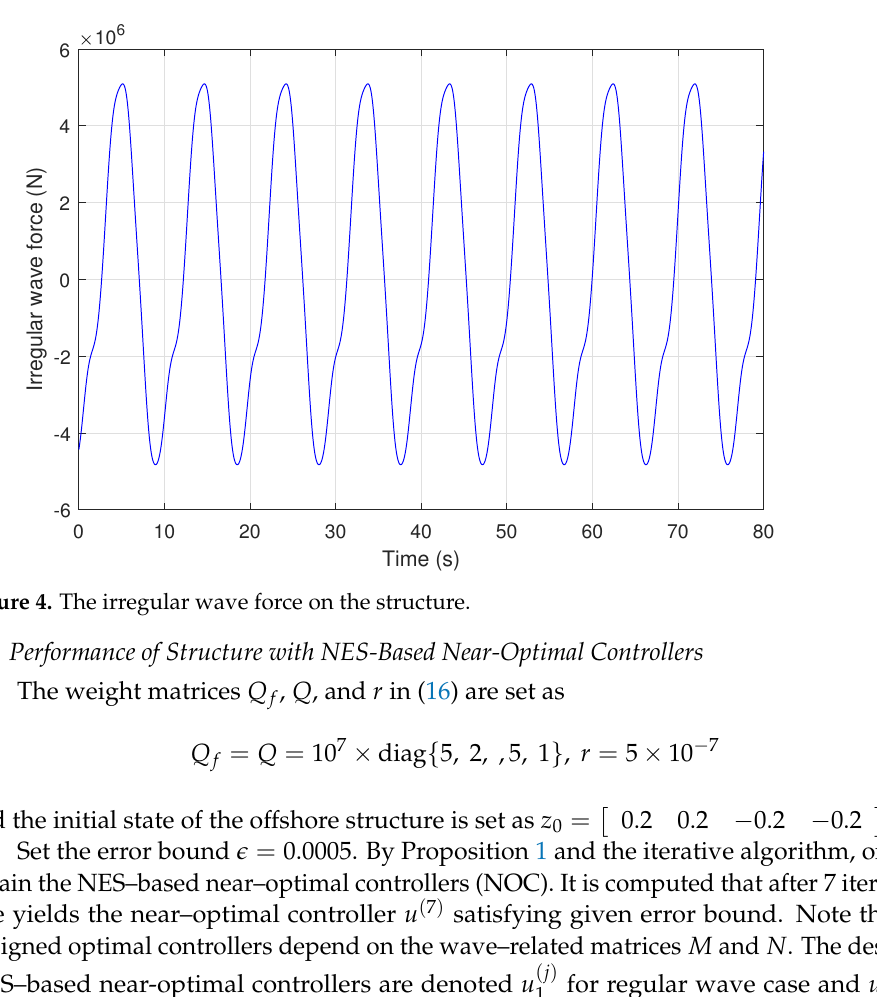
Figure 3. The regular wave force on the structure.